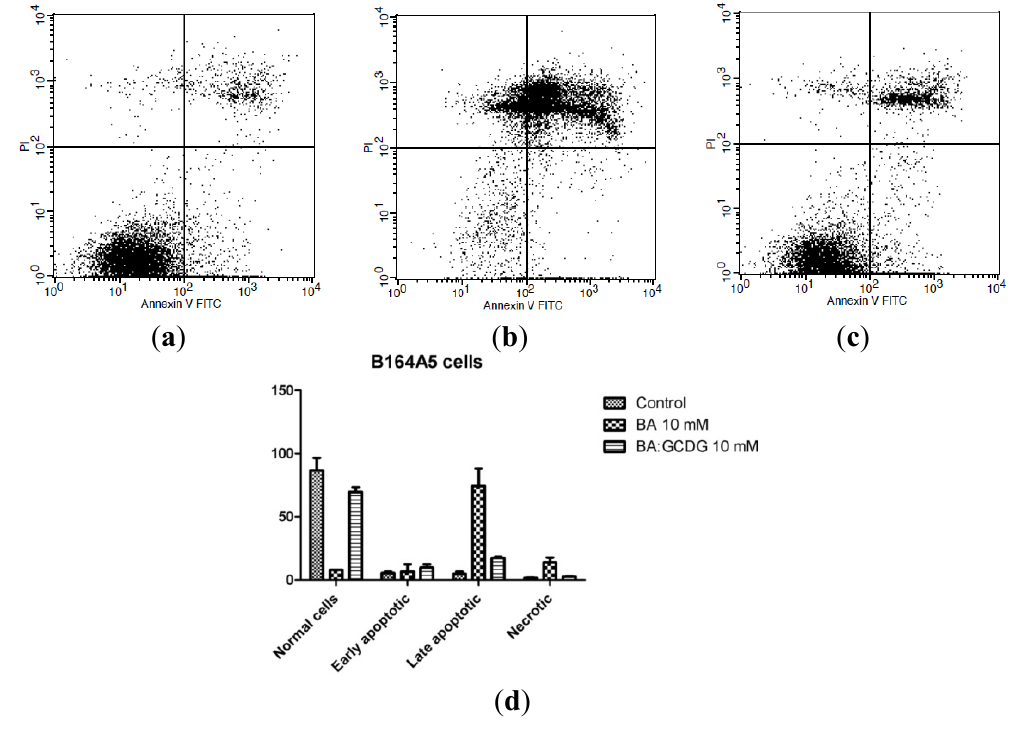
Figure 6. Representative dot-plots for Annexin V-FITC-PI-double staining after a period of incubation of 72 h for non-metastaticB164A5 cells: ( a ) Control; ( b ) BA 10